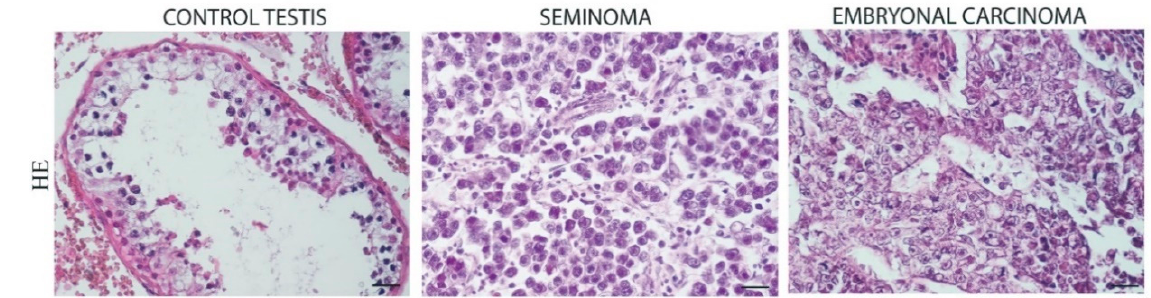
Figure 1. Hematoxylin and Eosin (HE) staining in control testis, Seminoma ( SE ), and Embryonal Carcinoma ( EC ). Scale bars: 25 μ m.